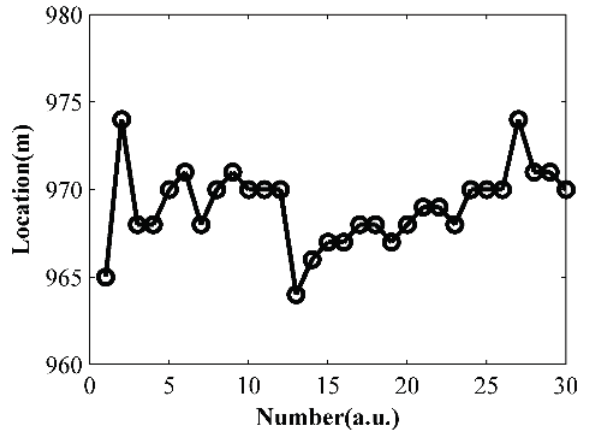
Figure 8. Locating results under 5000 ns pulse width.